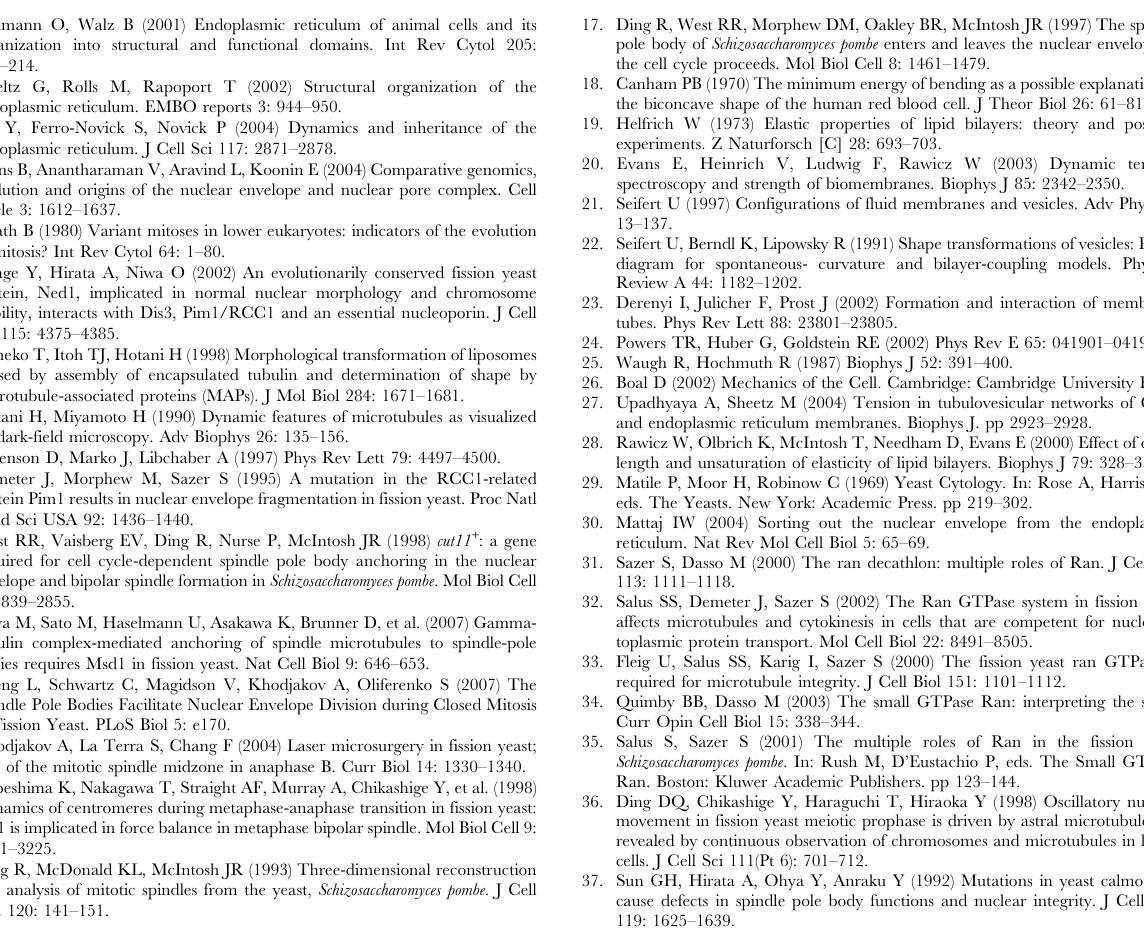
Figure S1 Minimal free energy, axial force of the n-MTB, area of the NE neutral surface, and geometry of the NE neutral surface as a function of the n-MTB length with constraints. Minimum NE free energy WNE (I), axial force FMT of the n-MTB (II), area A of the NE neutral surface S (III), and geometry of S (a–h and g 9 –h 9 ) as a function of the n-MTB length L, with the constraints T/B =40 m m-2, ti= 0, Vnet =4 p /3 =4.19 m m3, and r= 0.1 m m. FMT is the slope q WNE/ q L of the curve of minimum WNE as a function of L. The unit of length, L0 < 2.01 m m, is the length at which the n-MTB begins to push on the NE. The blue and red dots denote data points given by our numerical minimization method, corresponding to formation of stable and locally stable surfaces, respectively. The solid lines for L # L0 are described